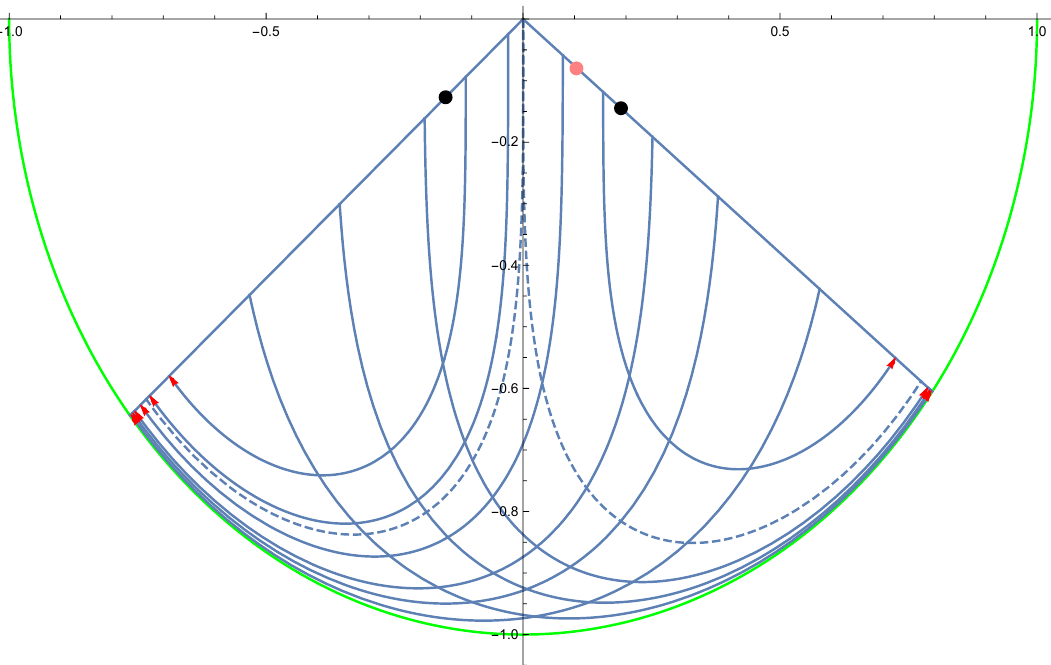
Figure 5. The space of curves with θ 1 = 0 . 7 , θ 2 = 0 . 65 . Neumann ends are denoted by red arrows, Dirichlet ends are unmarked. The black dots denote the D-walls, the dashed lines are the curves that connect the critical anchor to the defect, the pink dot is the Dirichlet critical